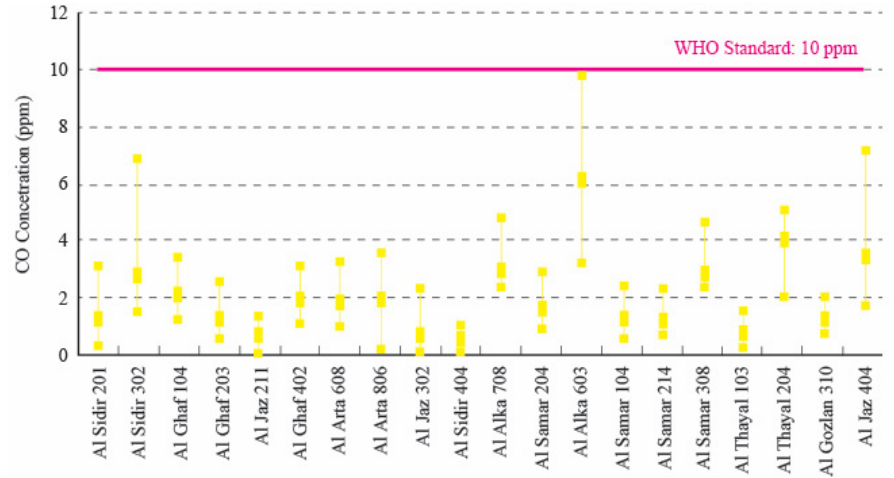
Figure 4. CO concentrations in 20 housing units at The Greens, Dubai.